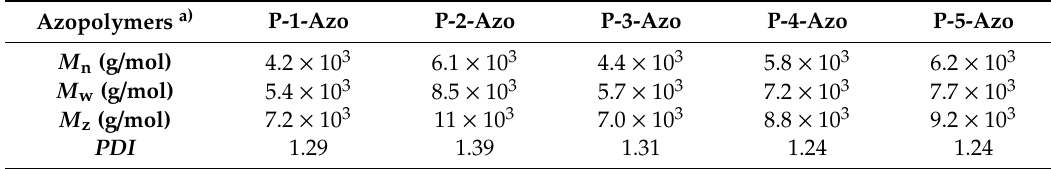
Table 1. Molecular weight and molecular weight distribution of